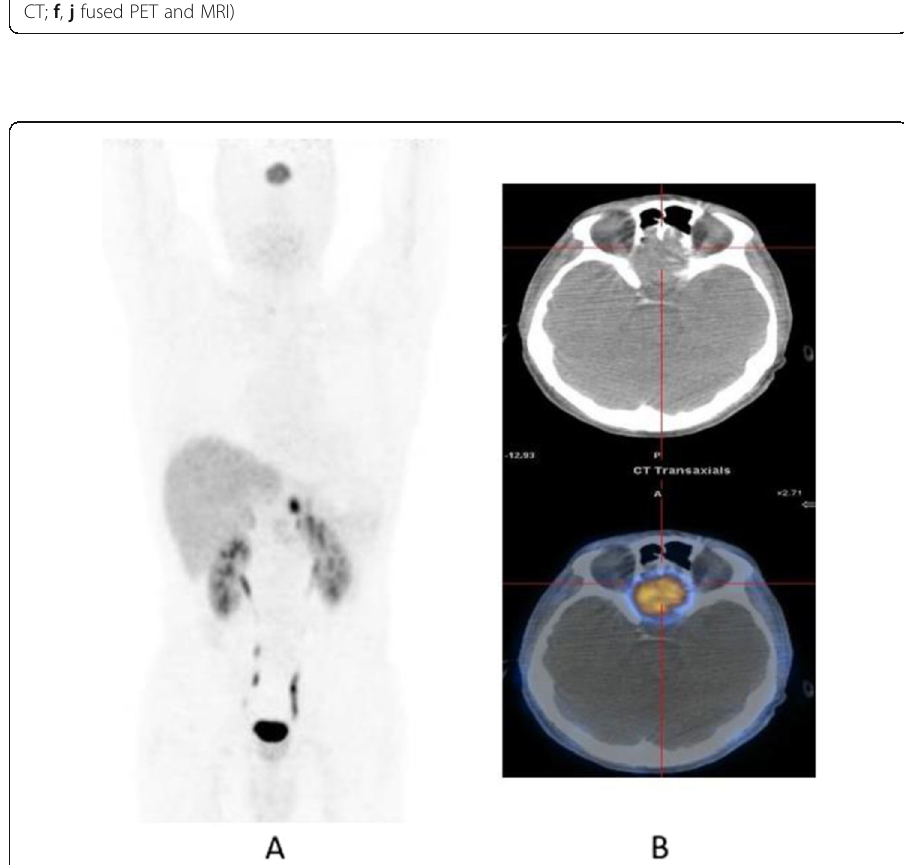
Fig. 65 68 Ga-DOTA peptide, meningioma. Clinical history : 57 y.o. woman with history of a NET of the tail of the pancreas (grade 1) treated with surgery. Suspect relapse in a peripancreatic lymph node. PET/CT findings : increased uptake in a peripancreatic lymph node consistent with relapse ( a MIP). Intense uptake in a large lesion in the base of the cranium consistent with a meningioma ( b CT and fused